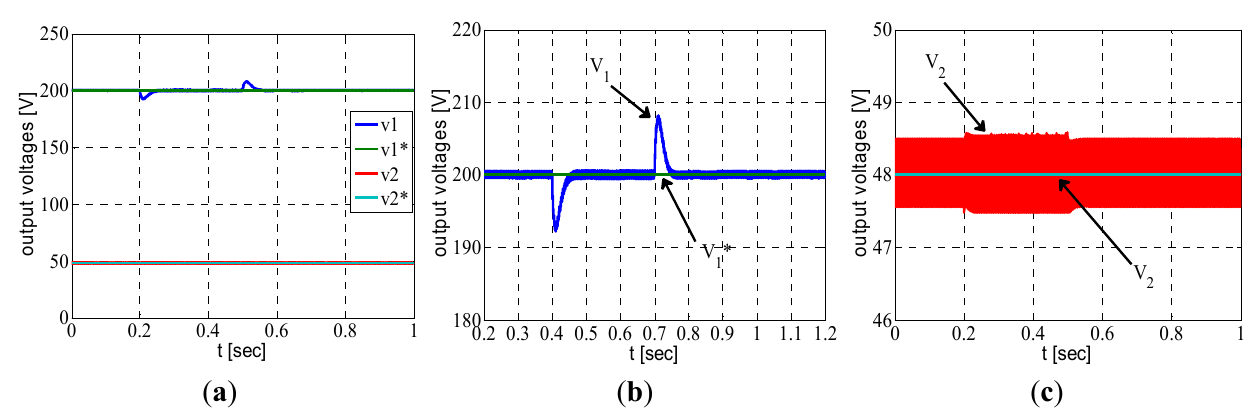
Figure 14. Load step variation results: ( a ) output voltages; ( b ) higher output voltage; ( c ) lower output voltage.